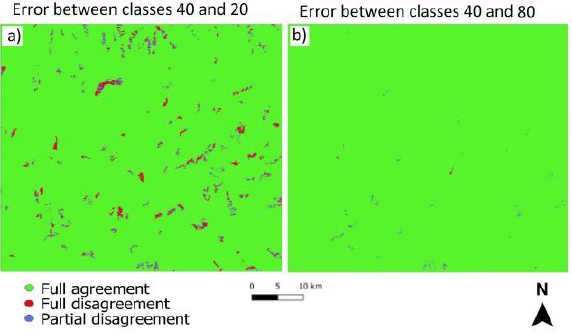
Figure 3. Example of inter-class error pattern